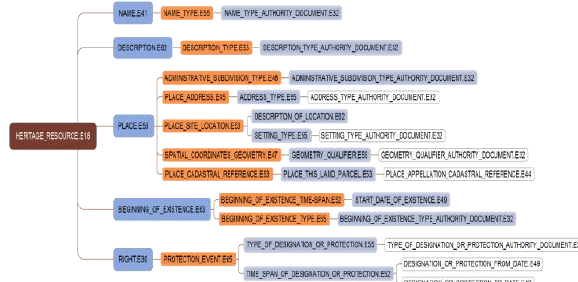
Figure 3. Example architecture diagram of ontology of historical settlement